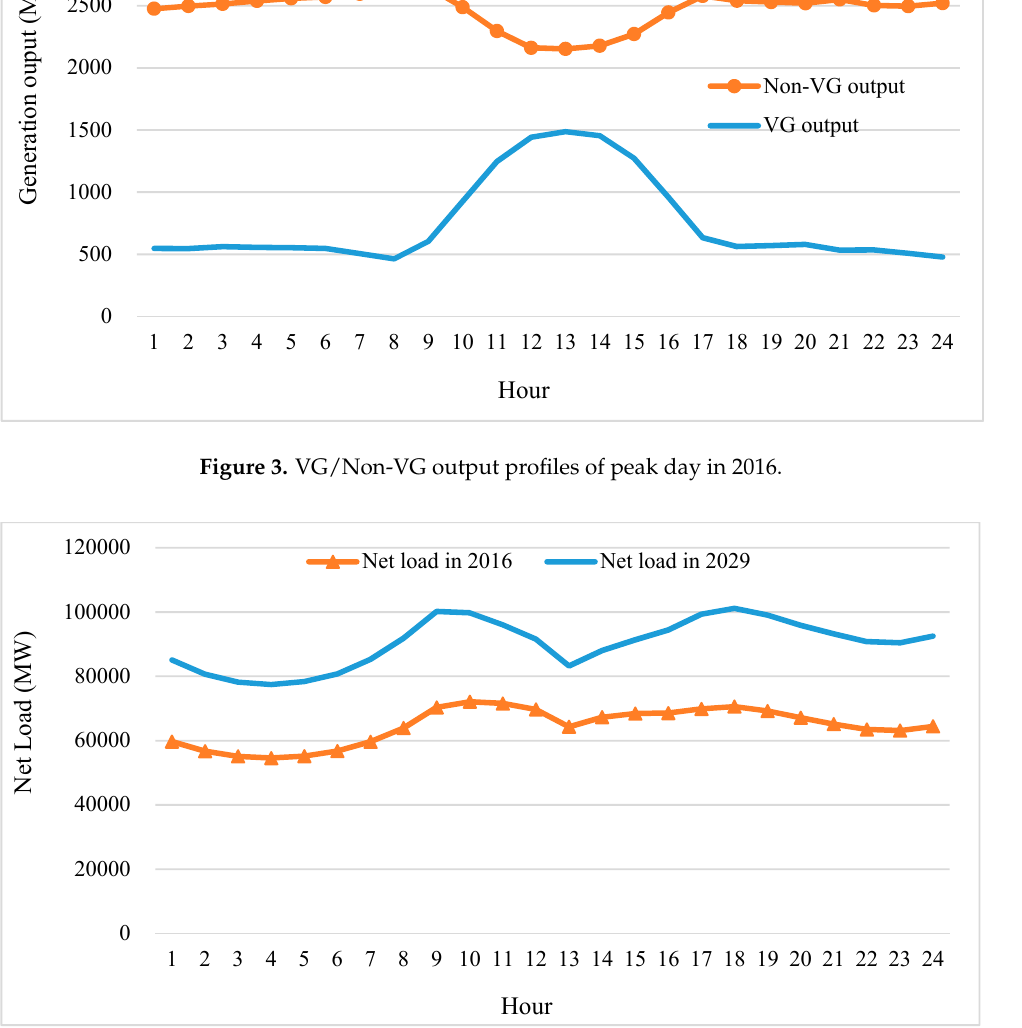
Figure 4. Net load profiles of peak day.